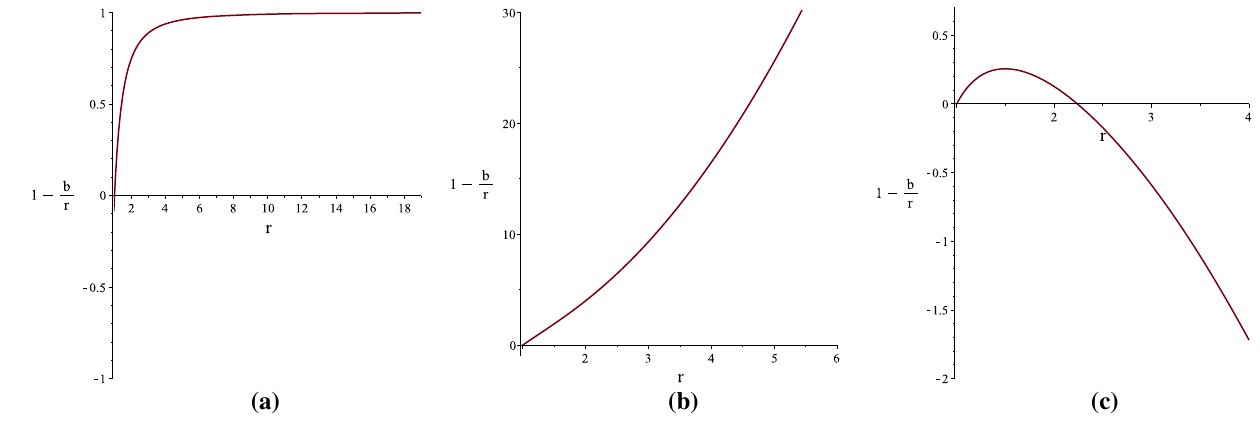
Fig. 1 a – c Show the asymptotically flat ( c 1 = 0), asymptotically hyperbolic ( c 1 = − 1) and asymptotically spherical ( c 1 = 1) wormhole solutions respectively. Wormhole throat is chosen at r 0 = 1, we also set n = 4 in these